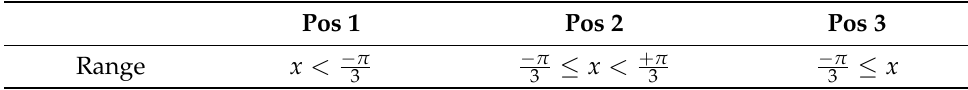
Figure 13. Y Euler angle and estimated limb pose labels recorded during calibration session for subject 10. Each colored line represents the recording of one hand’s motion during calibration. The Y Euler angle was plotted for each sample point and compared to predefined thresholds (red dashed lines), resulting in a limb pose label. Table 3. Euler angle ranges for position estimation.